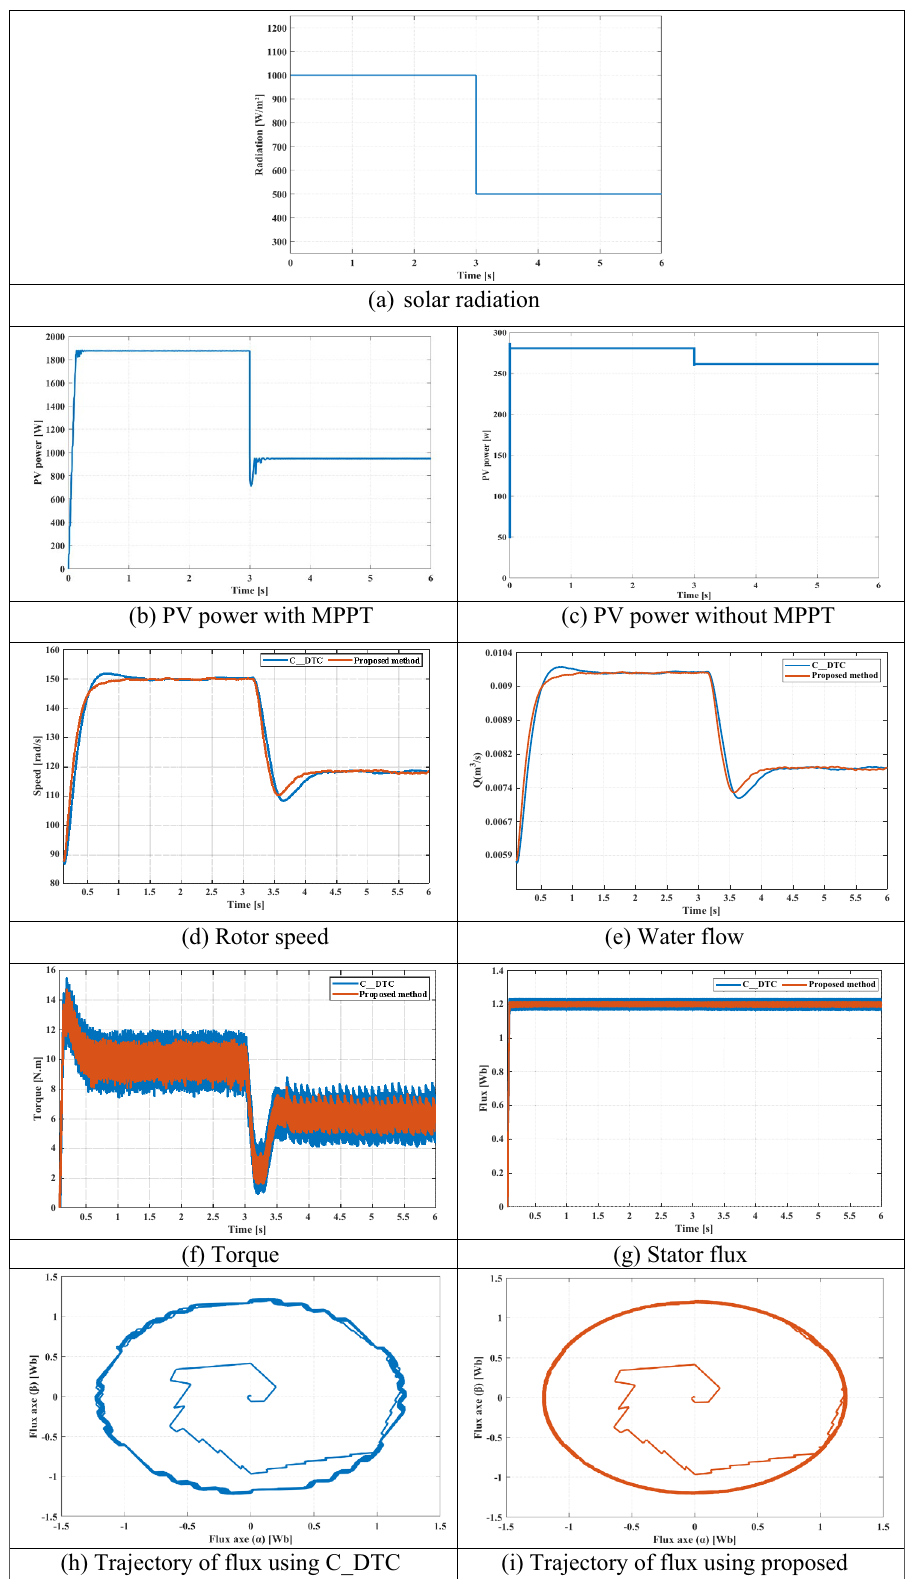
Fig. 11 Performance of PV sys‑ tem under variable